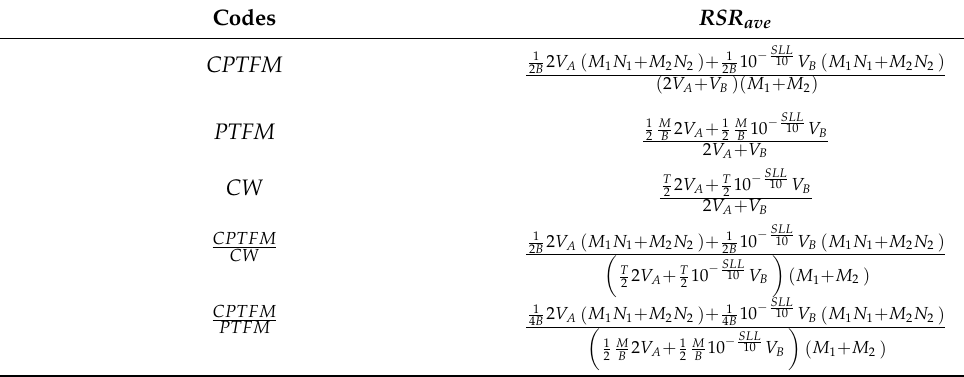
Table 1. RSR ave for CW, PTFM, and CPTFM waveforms in zones A and B.